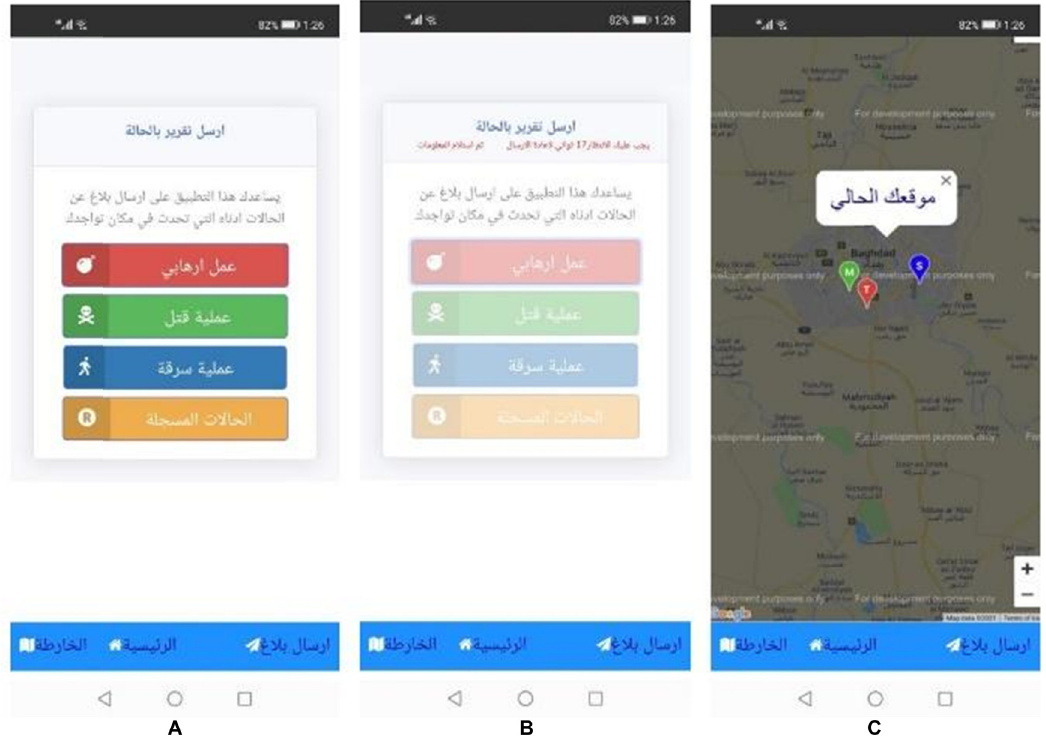
Figure 8: Home screen and map of the mobile - based application. ( A ) Home screen to send a report. ( B ) Screen to con fi rm sending the report. ( C ) Location